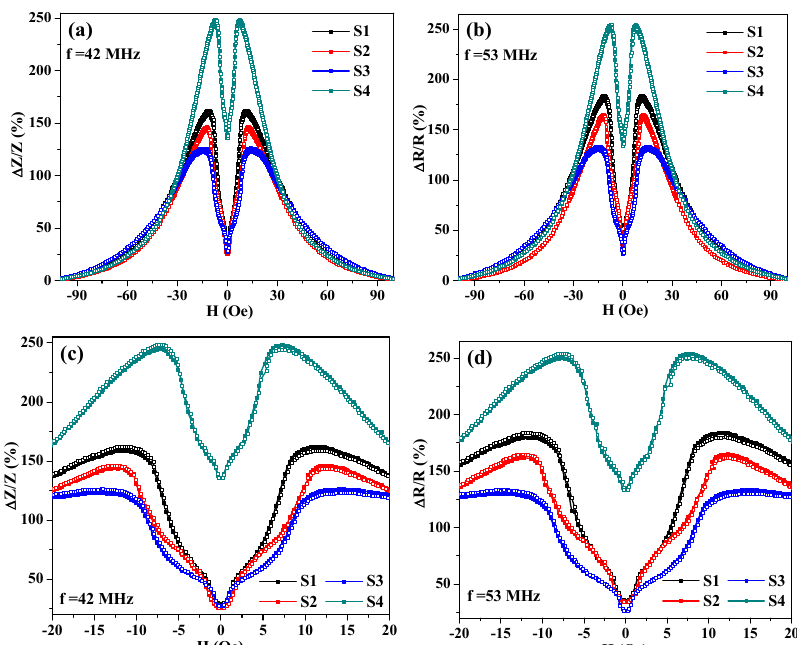
Figure 4. MOKE hysteresis loops taken from the same turning sections of the three-turn ( a ) and six-turn ( b ) Co 75 Fe 10 Ni 2 Si 8 B 5 meander samples.